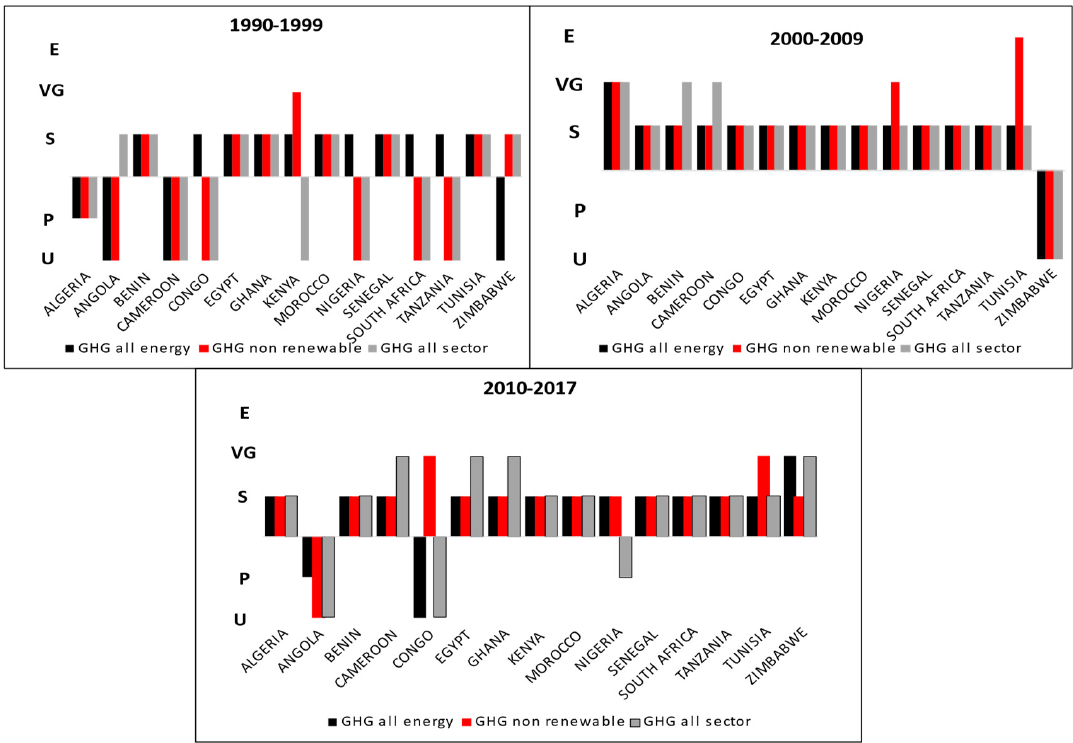
Figure 4. EWF’s GHG footprint-Water’s GHG footprint.